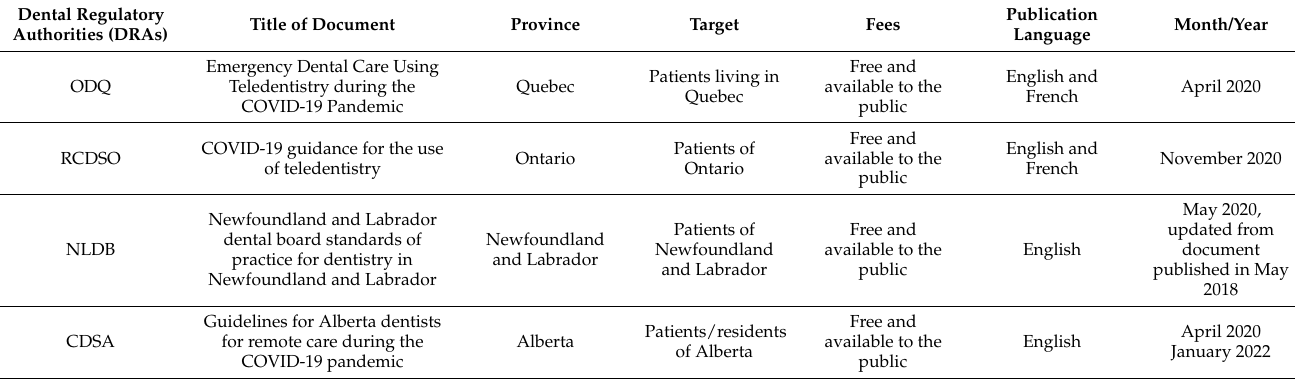
Table 1. Attributes of teledentistry-related Clinical Practice guidances